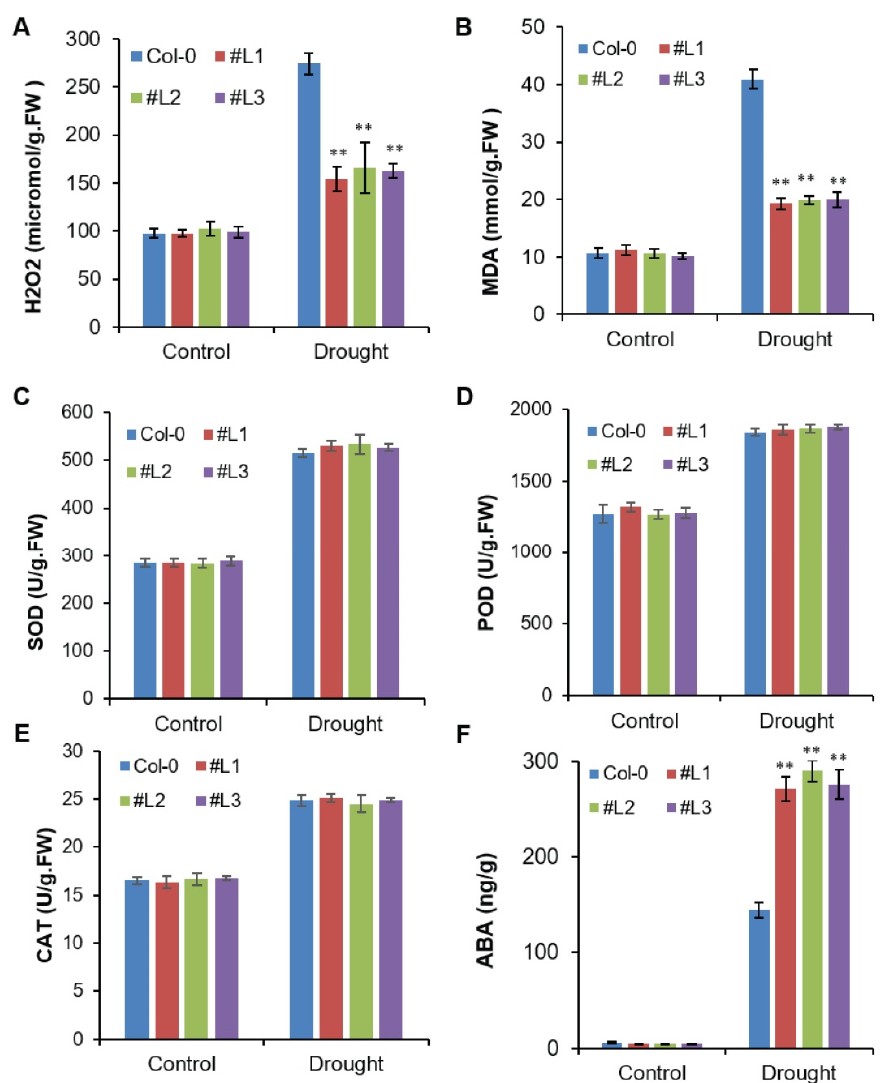
Figure 5. Reactive oxygen species (ROS) and antioxidant response under drought stress in OsHSFA3 -overexpressing transgenic Arabidopsis plants. Quantitative measurement of H 2 O 2 ( A ), malondialdehyde ( B ), superoxide dismutase (SOD) ( C ), peroxidase (POD) ( D ), catalase (CAT) ( E ) and ABA ( F ) in WT and OsHSFA3 -overexpressing transgenic Arabidopsis plants under control and drought stress. Values indicate mean ± SE of 10 biologically independent samples. Significance of data is tested with Student’s t test. ** represents p < 0.01.